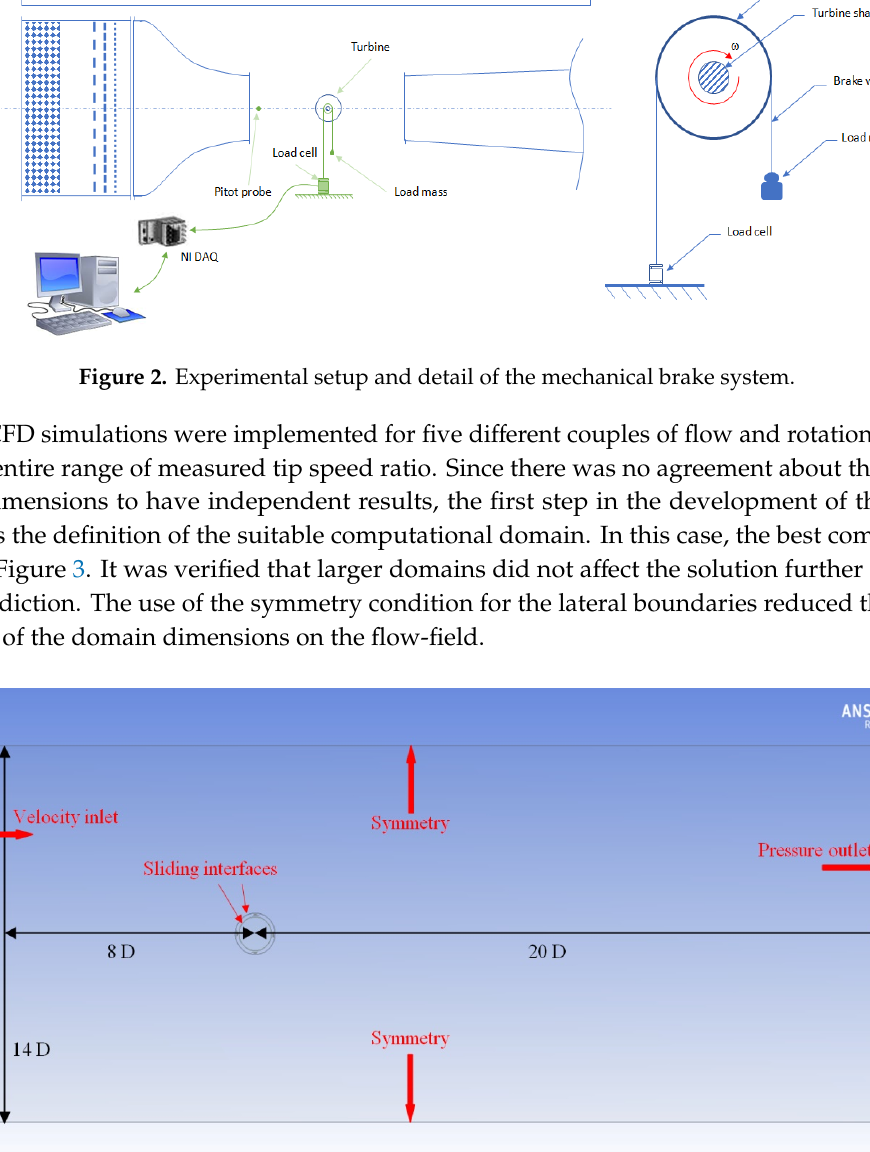
Figure 3. Computational domain dimensions and boundary conditions.